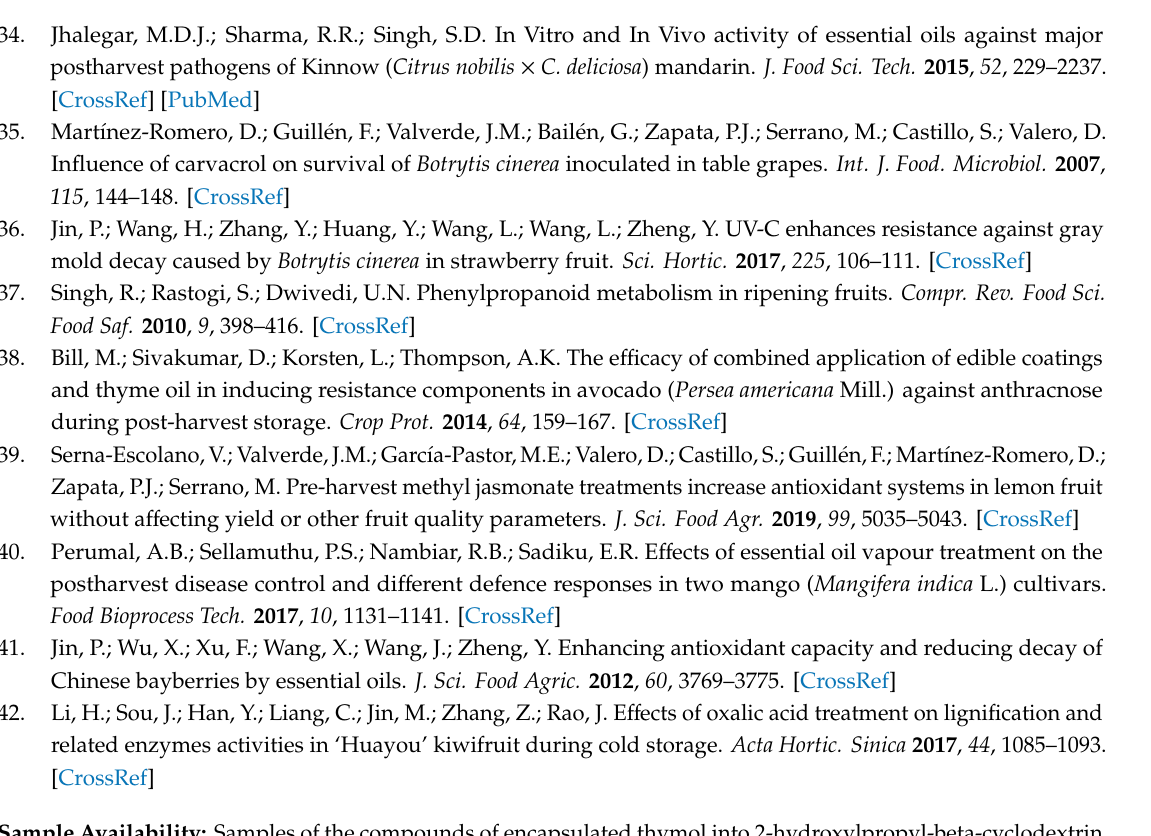
Sample Availability: Samples of the compounds of encapsulated thymol into 2-hydroxylpropyl-beta-cyclodextrin are available from the